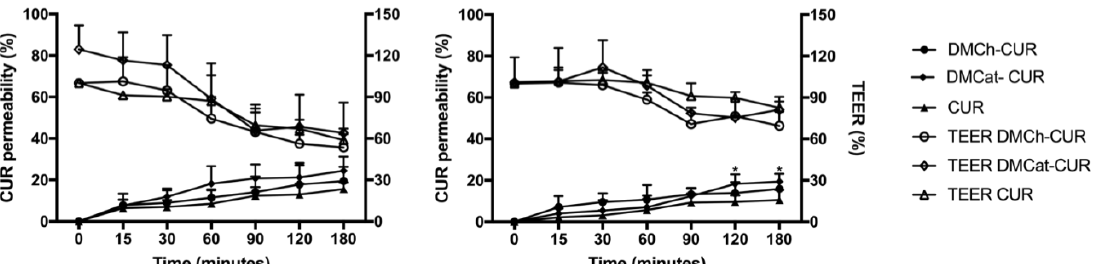
Figure 7. In vitro permeability profile of DMCh-CUR, DMCat-CUR, and free CUR across Caco-2 monoculture model ( left ) and across Caco-2/HT29-MTX:Raji B triple co-culture model ( right ) expressed in percentage. All experiments were conducted from the apical to basolateral compartment in 1% ( v / v ) DMSO in HBSS at 37 °C. Error bars represent mean ± SD ( n = 3) and * p < 0.05 denotes a significant difference between DMCat-CUR and CUR.